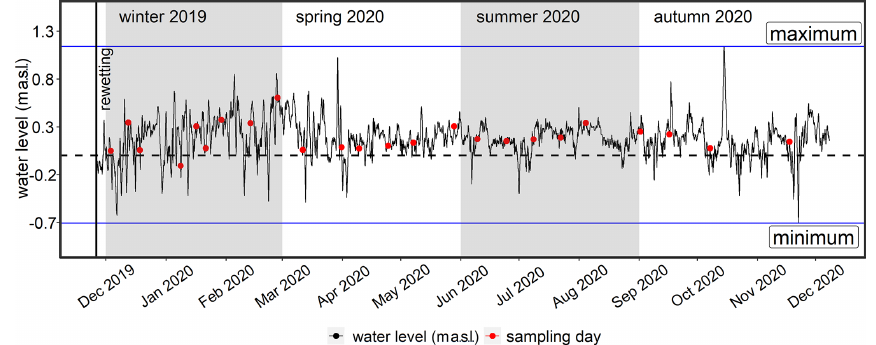
Figure A1. Water level data from the monitoring station Barhöft (Wasserstraßen- und Schifffahrtsamt Ostsee), representing the Kubitzer Bodden, from the beginning of rewetting (26 November 2019) until the end of the investigation period. The red dots indicate the sampling days. The dashed horizontal line represents 0ma.s.l. The minimum and maximum water levels of the investigation period are shown by the blue horizontal lines ( − 0.7 and 1.1ma.s.l., respectively). See also Figs. A2 and A3.